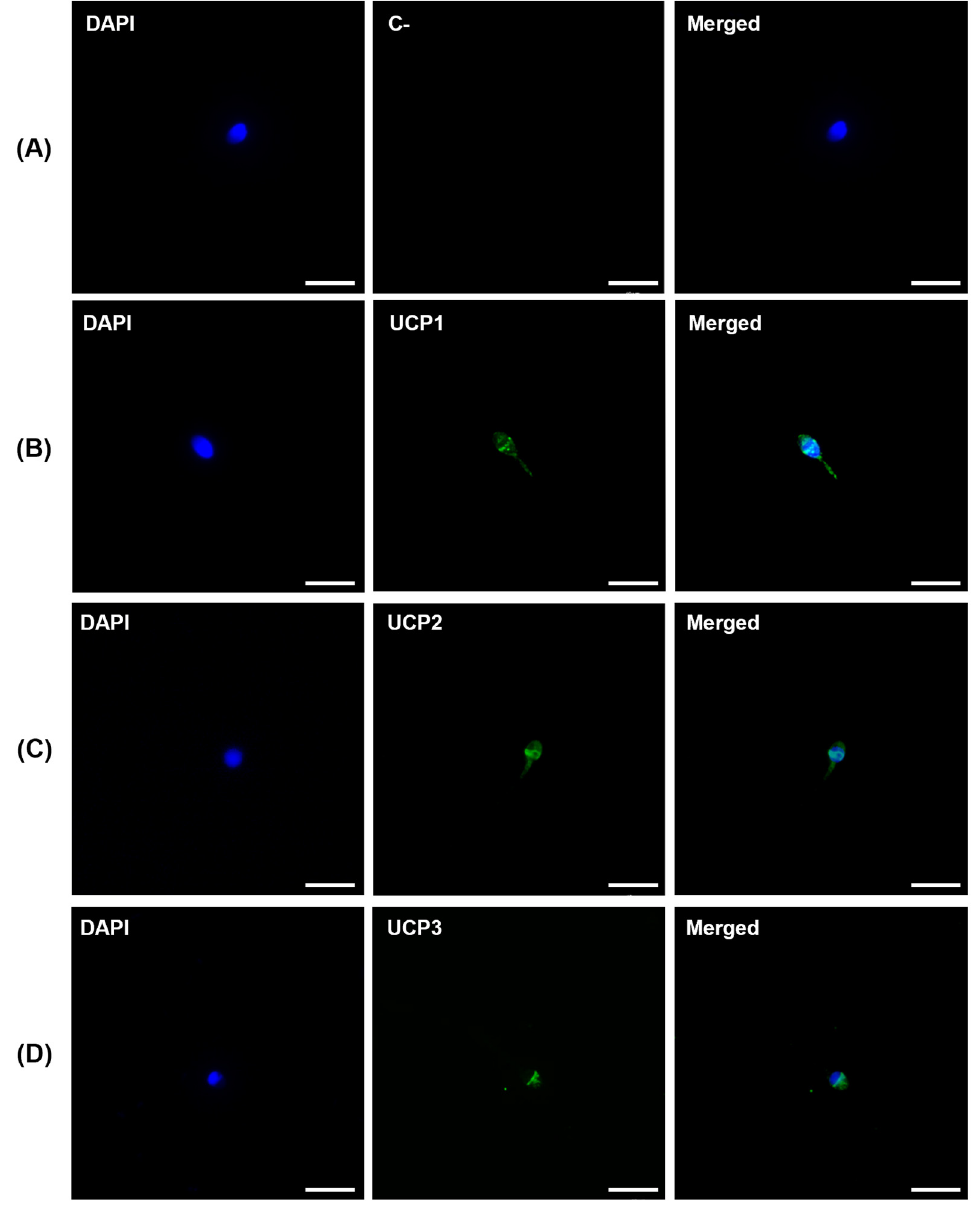
Figure 3. Immunofluorescence staining for UCP1, UCP2, and UCP3 protein expression in human spermatozoa. ( A ) Negative control. Immune labeling of UCP1 ( B ), UCP2 ( C ), and UCP3 ( D ) was observed in human spermatozoa. Scale bar—10 µm.